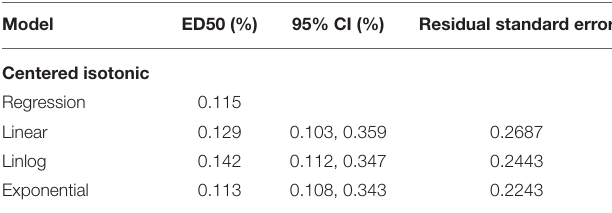
TABLE 2 | The median effective analgesic concentration (MEAC) and 95% confidence interval of the different